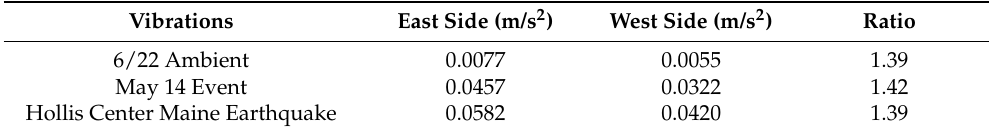
Table 4. Peak displacements at the vertical